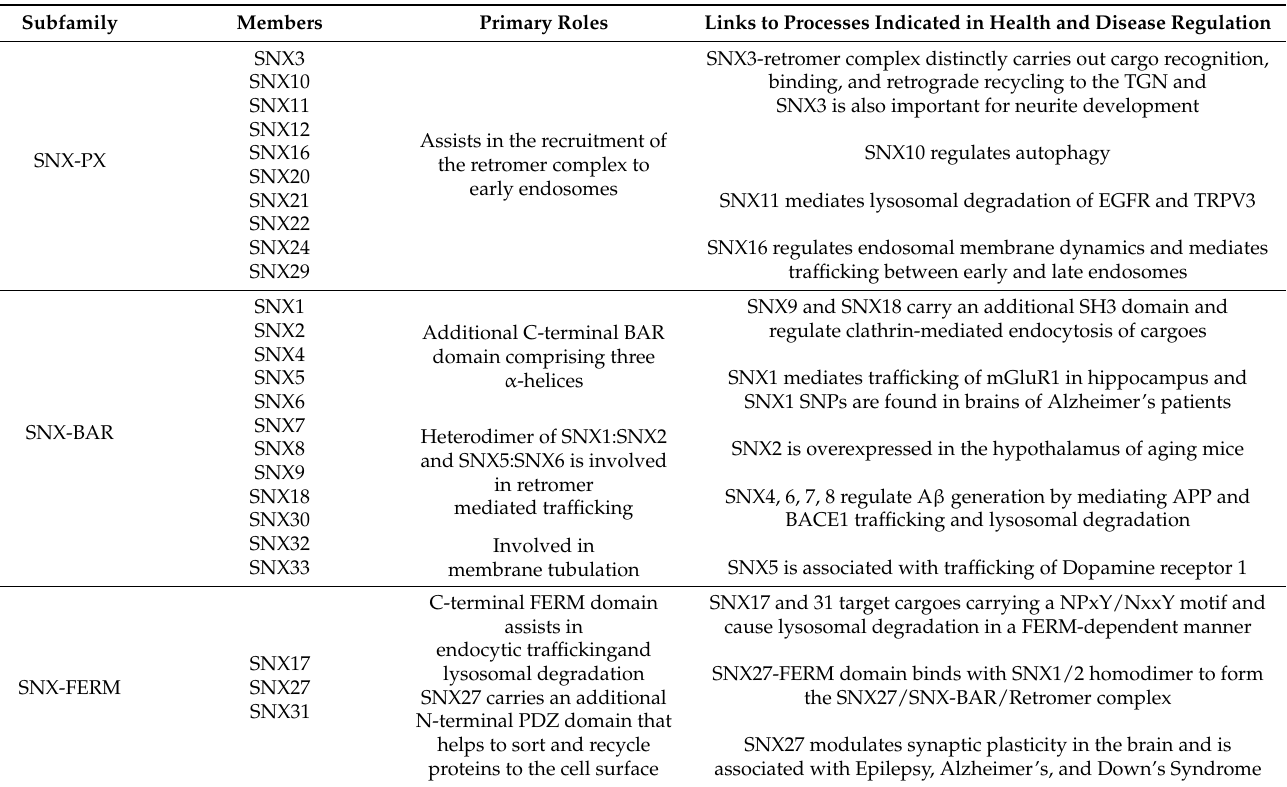
Table 1. Characteristic features of different SNX